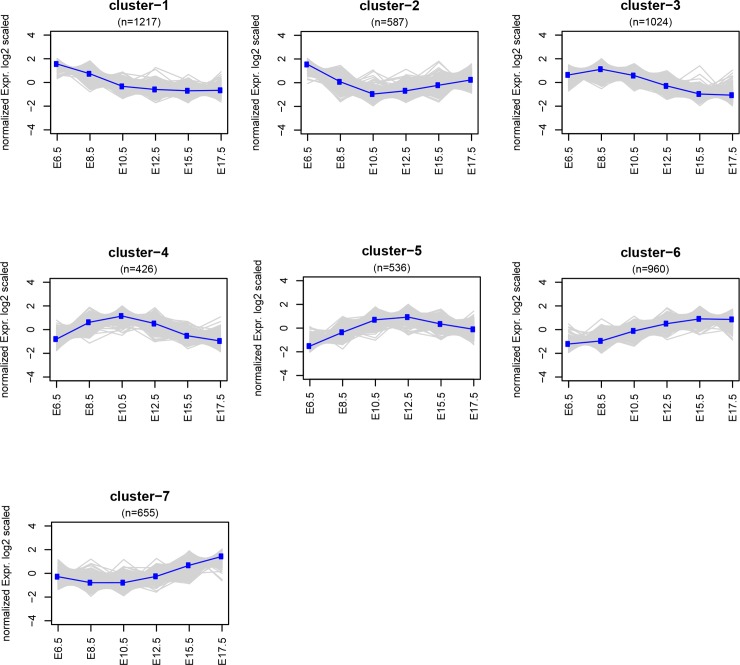
K-means cluster analysis.K-means clustering of differentially expressed genes changing over time (DEGots) from E6.5 to E17.5. The 5405 DEGots are clustered by K-means algorithm. n: number of genes in each cluster.